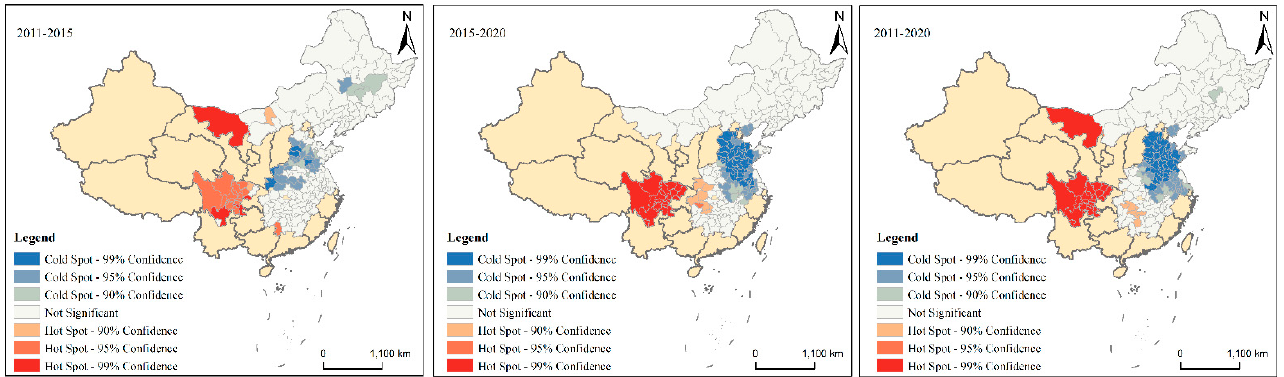
Figure 5. Hot spot analysis of non-grain production ratio changes in 2011–2015, 2015–2020,